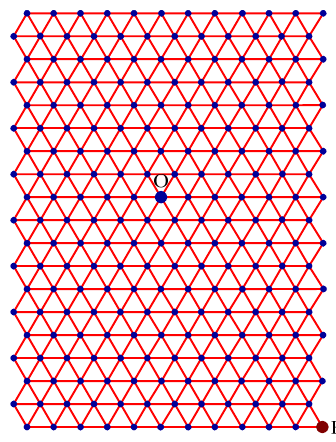
Figure 10. Node O is the source and node E is the eccentric node of O. The wrapping edges between the first column and the last column are not drawn.